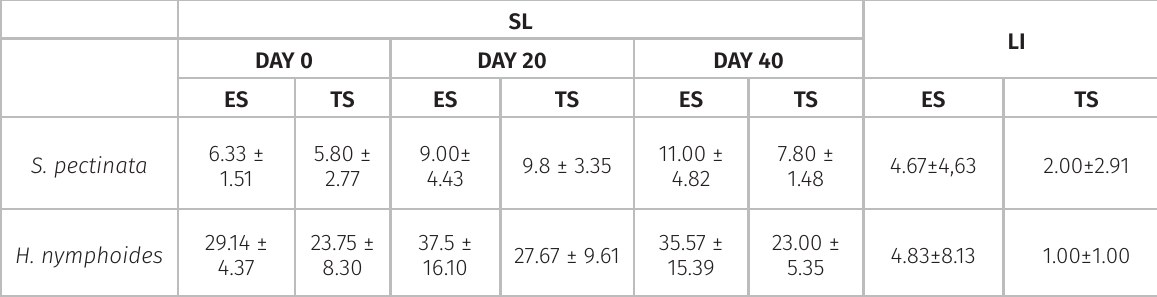
Table I. Mean ± Standard deviation of shoot lengths (SL, cm) and length increase (LI = final SL– initial SL, cm) at the extraction (ES) and transplant (TS) sites during the